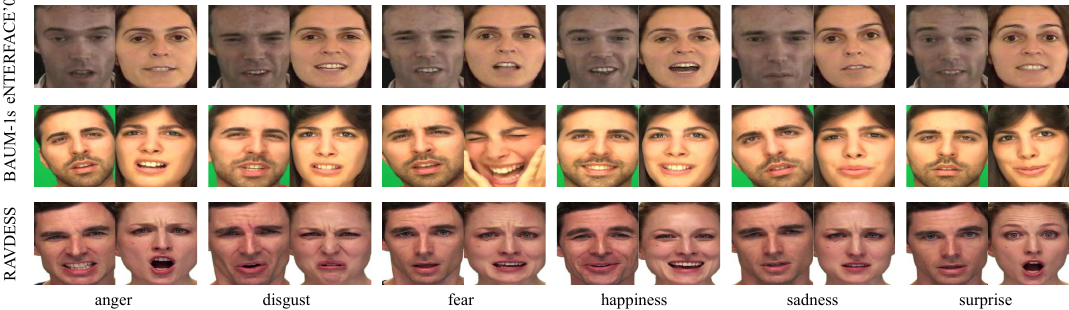
Figure 2. Some cropped facial images from the eNTERFACE’05, BAUM-1s, and RAVDESS